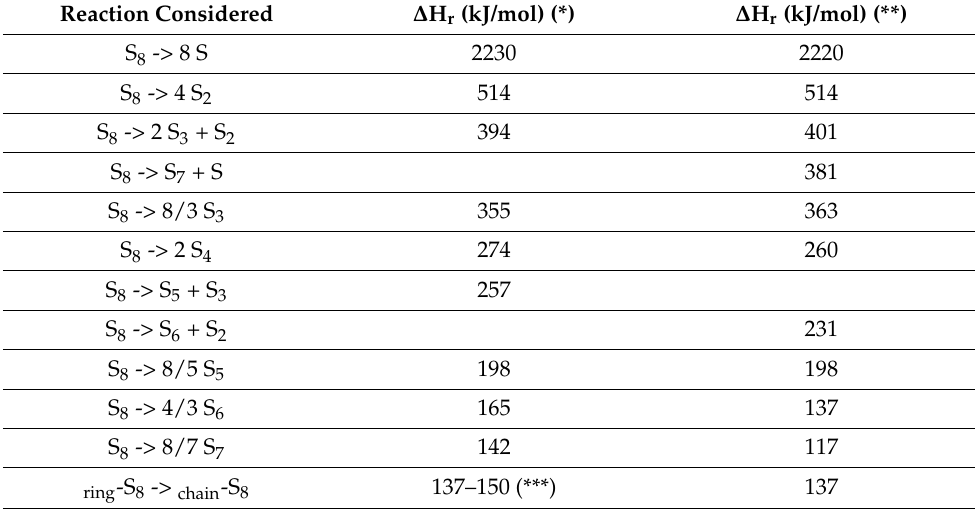
Table 4. Enthalpy of reaction cyclooctasulfur ring scission into radicals. Reaction